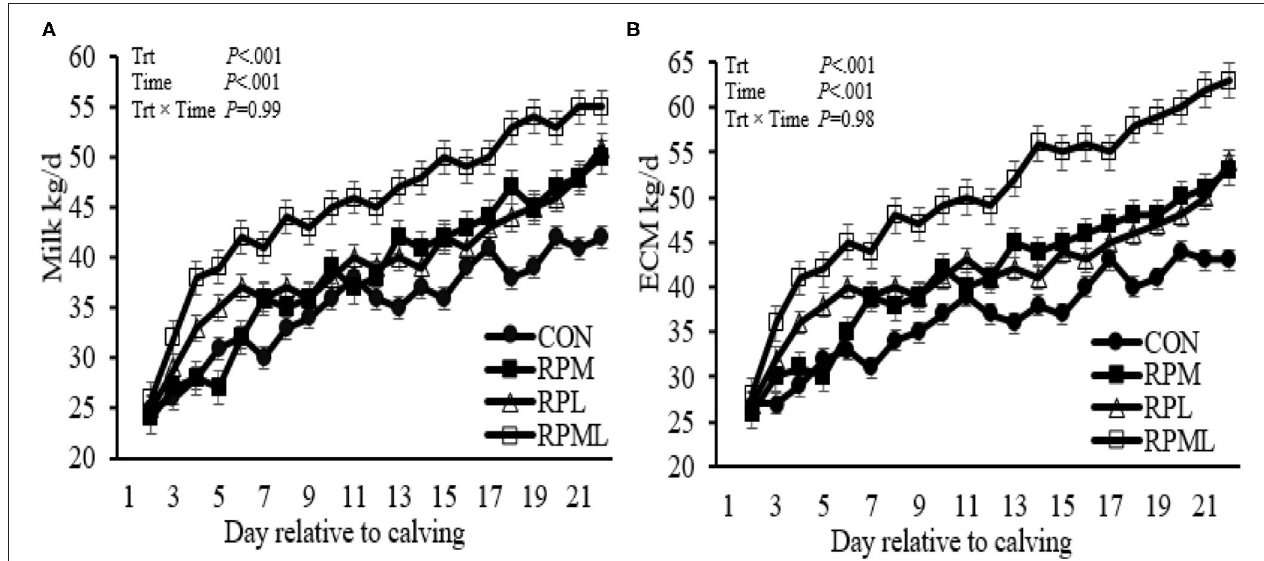
FIGURE 3 | Effect of ruminally protected Lys and Met supplementation on milk production, energy-corrected milk yield of Holstein dairy cows during the transition period. Values are means; standard errors are represented by vertical bars.